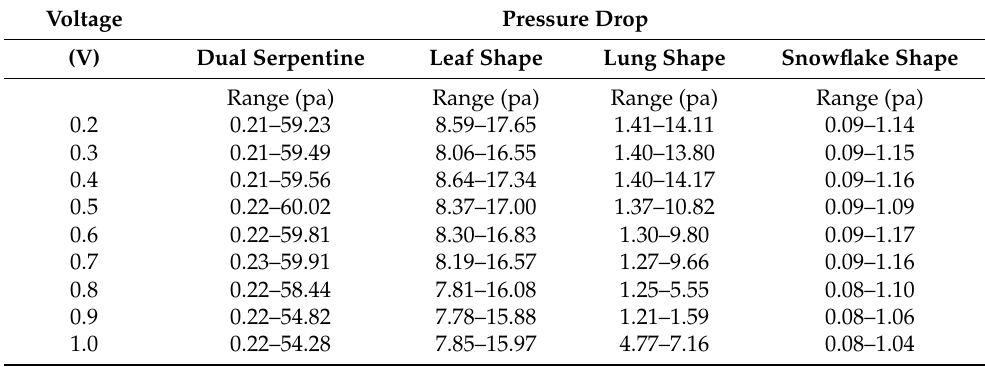
Table 3. The pressure drops for the PEM fuel